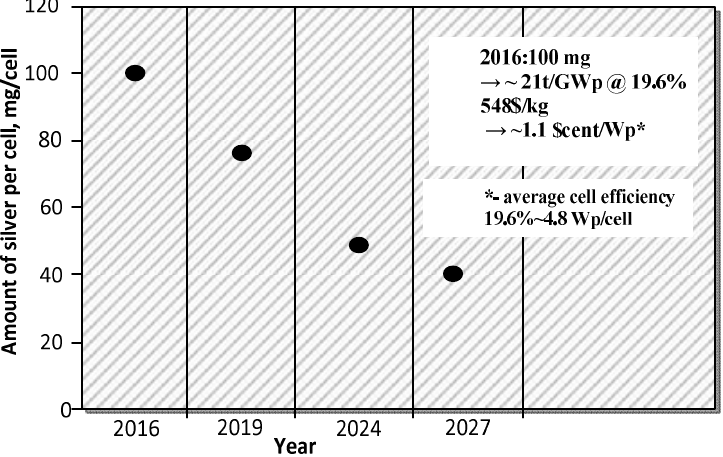
Figure 1. Prediction of the reduction in the use of Ag in paste applied for contact deposition [5].